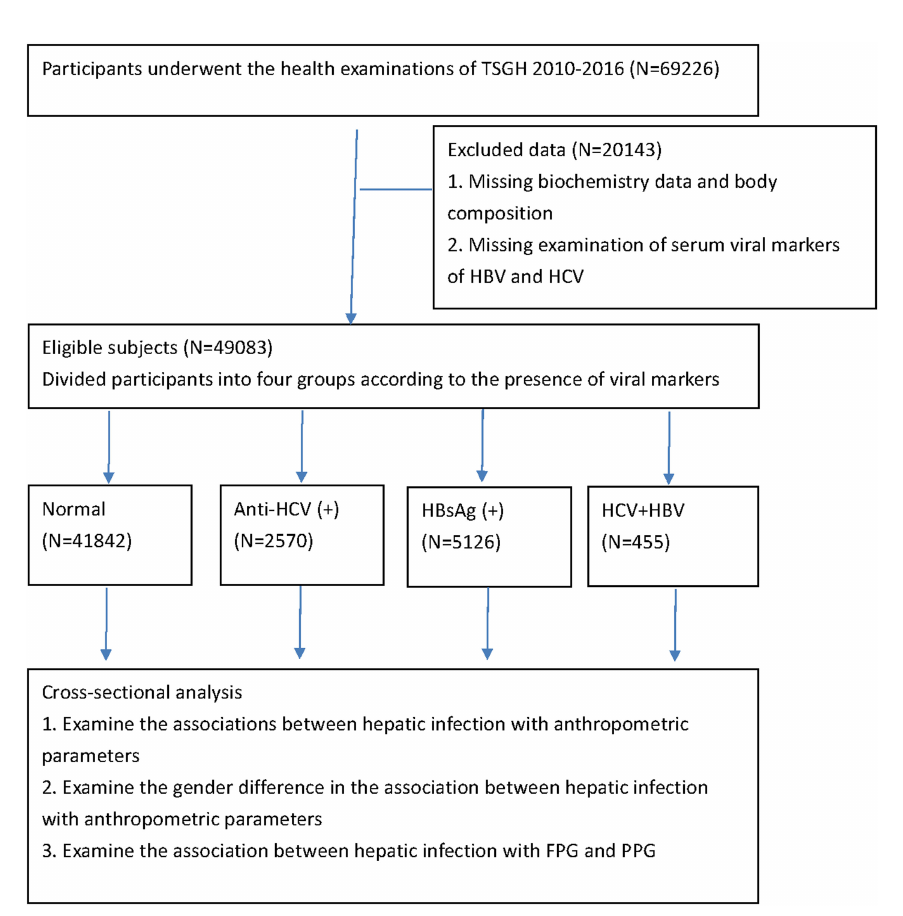
Fig 1. Flow chart of